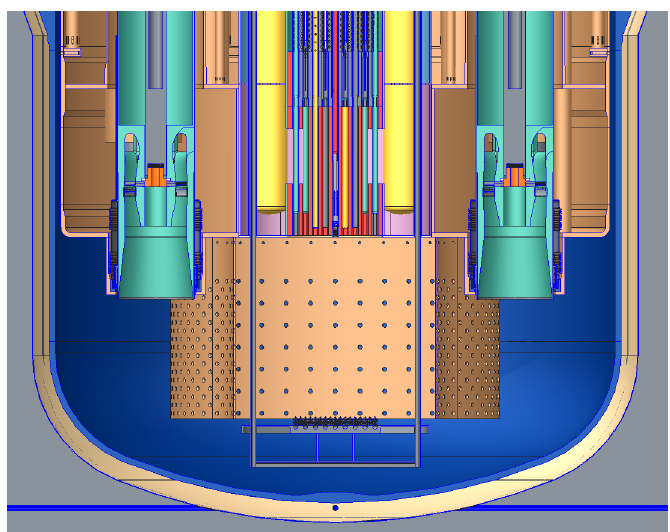
Fig. 6. – MYRRHA reactor core with reactor experiments and spallation target in the red